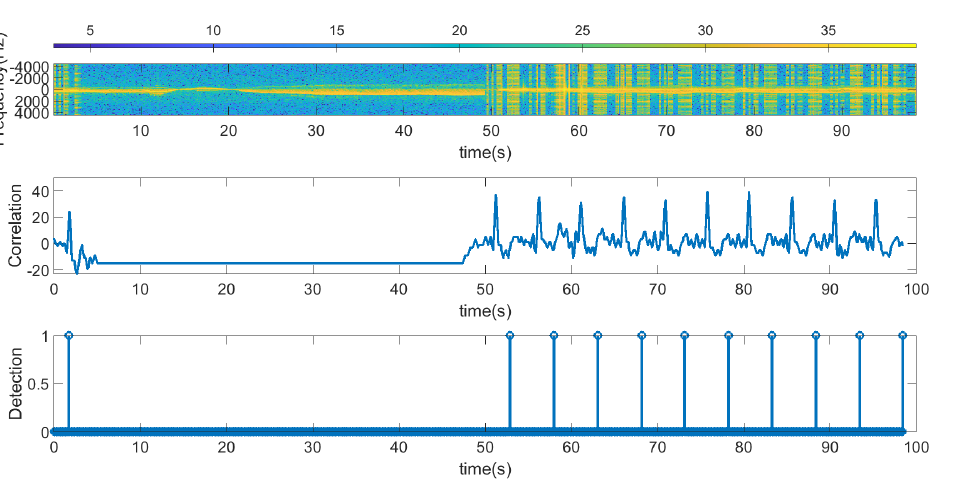
Figure 28. Data measurement using length 13 Barker codes when the scooter is in motion. From top to bottom: raw spectrogram before CFAR processor is applied, the output of the correlator signal and tag detection. In this case, the tag is partially out of range.